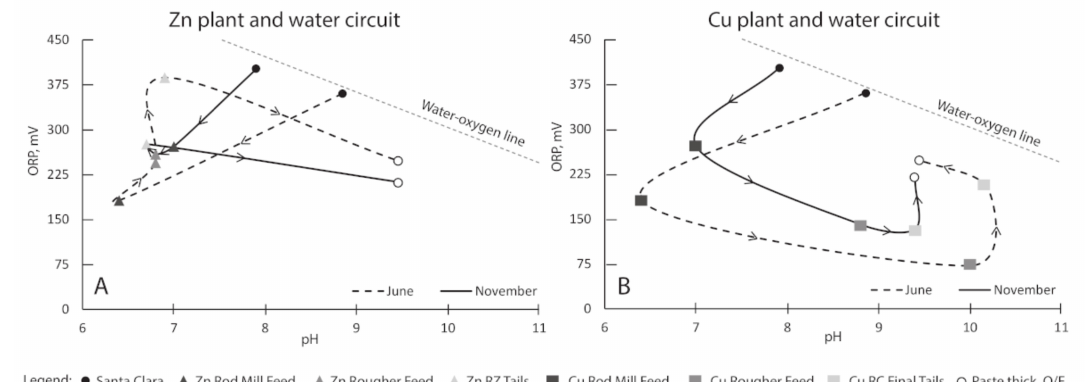
Figure 2. ORP–pH curves from samples with in situ measurements from water ciruits within ( A ) the Zn plant, ( B ) the Cu